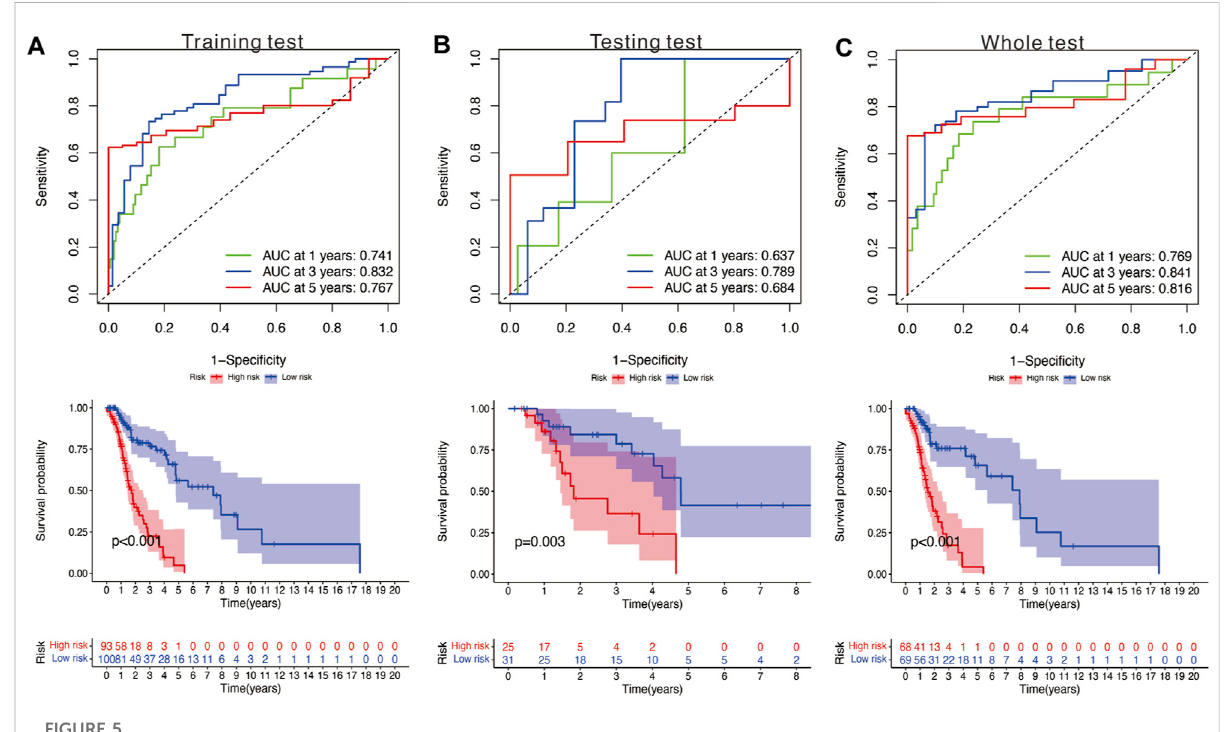
FIGURE 5 (A) Time-dependent ROC analysis and survival analysis of the nine-gene signature in the training set. (B) Time-dependent ROC analysis and survivalanalysisofthenine-genesignatureinthetestingset. (C) Time-dependentROCanalysisandsurvivalanalysisofthenine-genesignatureinthe whole